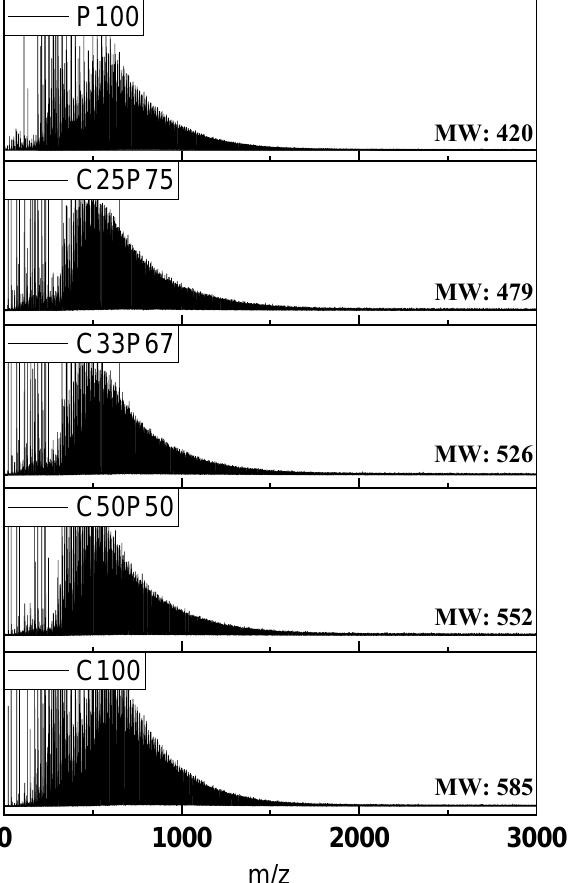
Figure 2. MALDI TOF-MS spectra of spinnable pitches prepared by co-carbonization of purified coal tar pitch and PFO in various ratios.